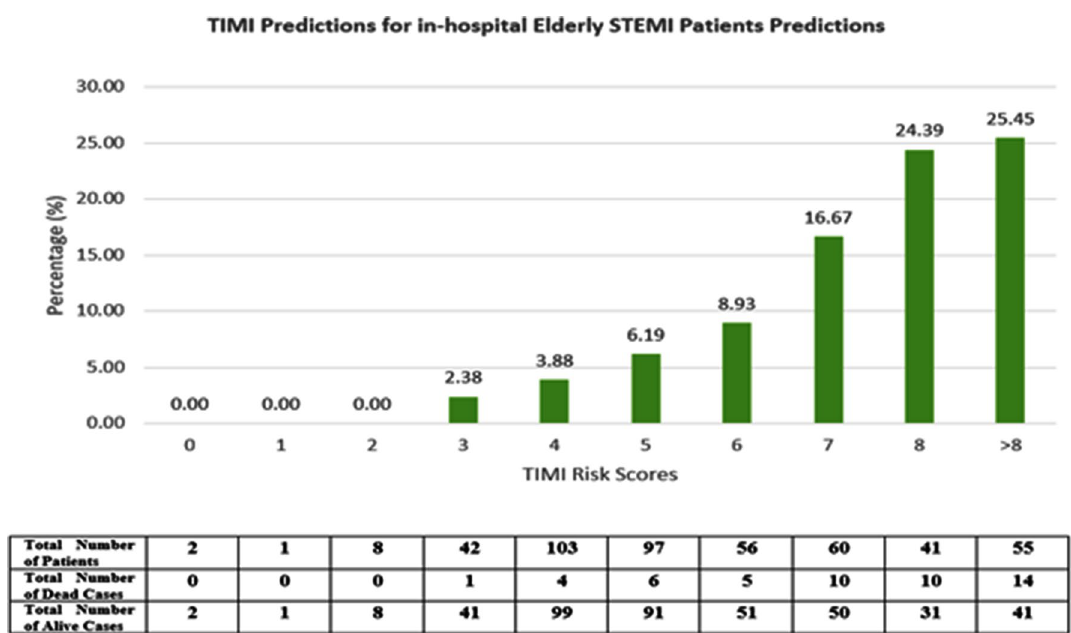
Figure 2. Mortality rate distribution on the validation set of TIMI risk